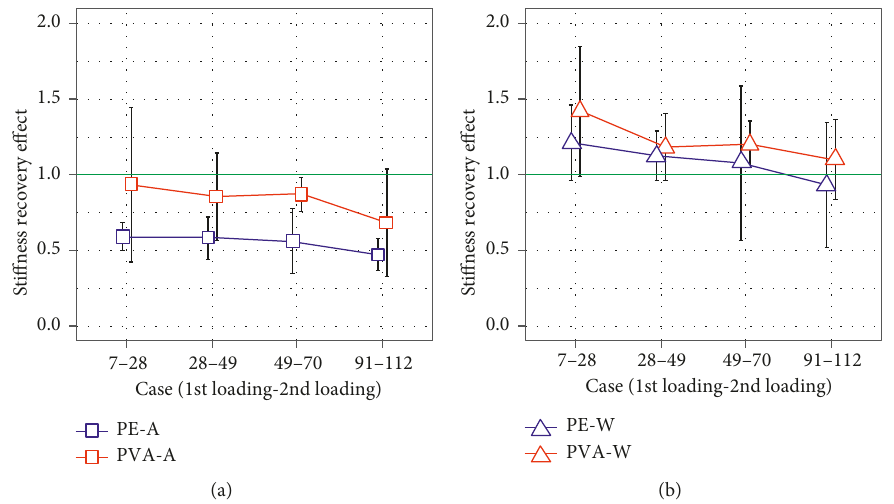
Figure 9: Stiffness recovery effect: (a) air environment; (b) water environment.